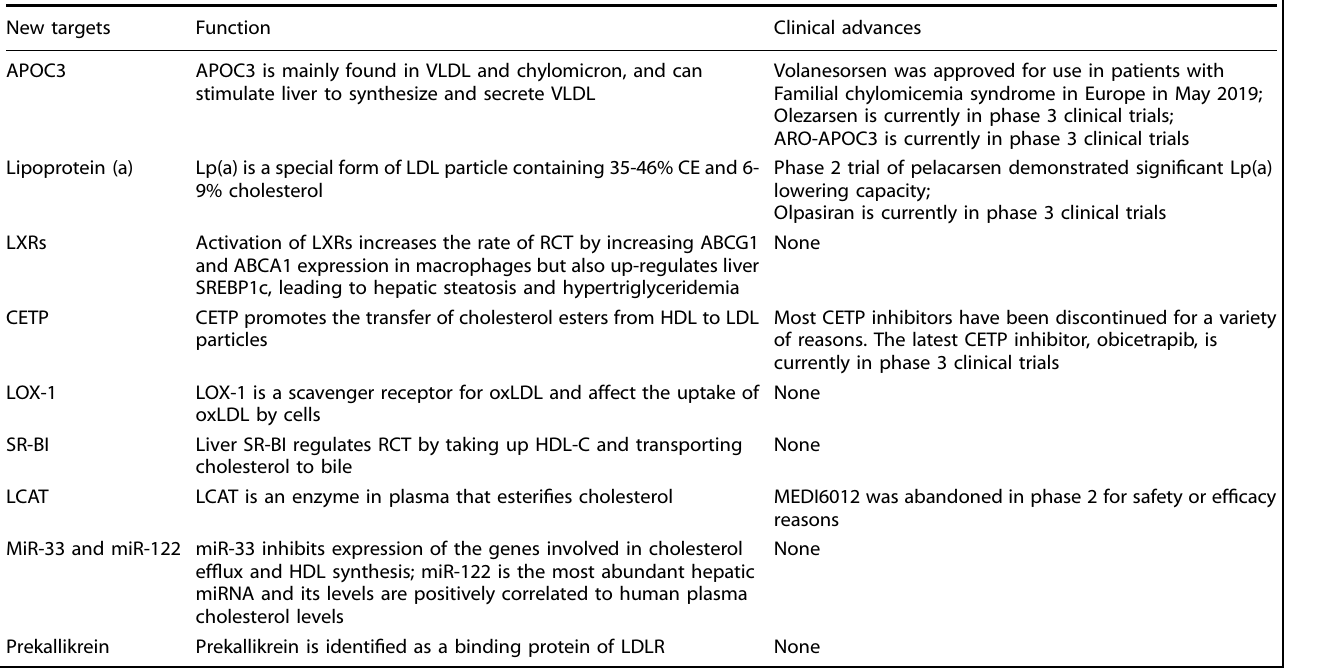
Table 2. New targets and their clinical advances New targets Function